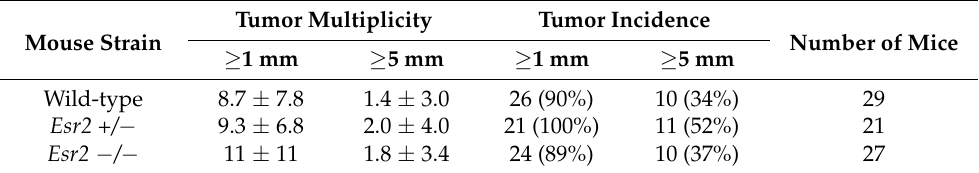
Table 3. Effect of Estrogen Receptor- β on liver tumor multiplicity and incidence in females. Tumor Multiplicity Tumor Mouse Strain